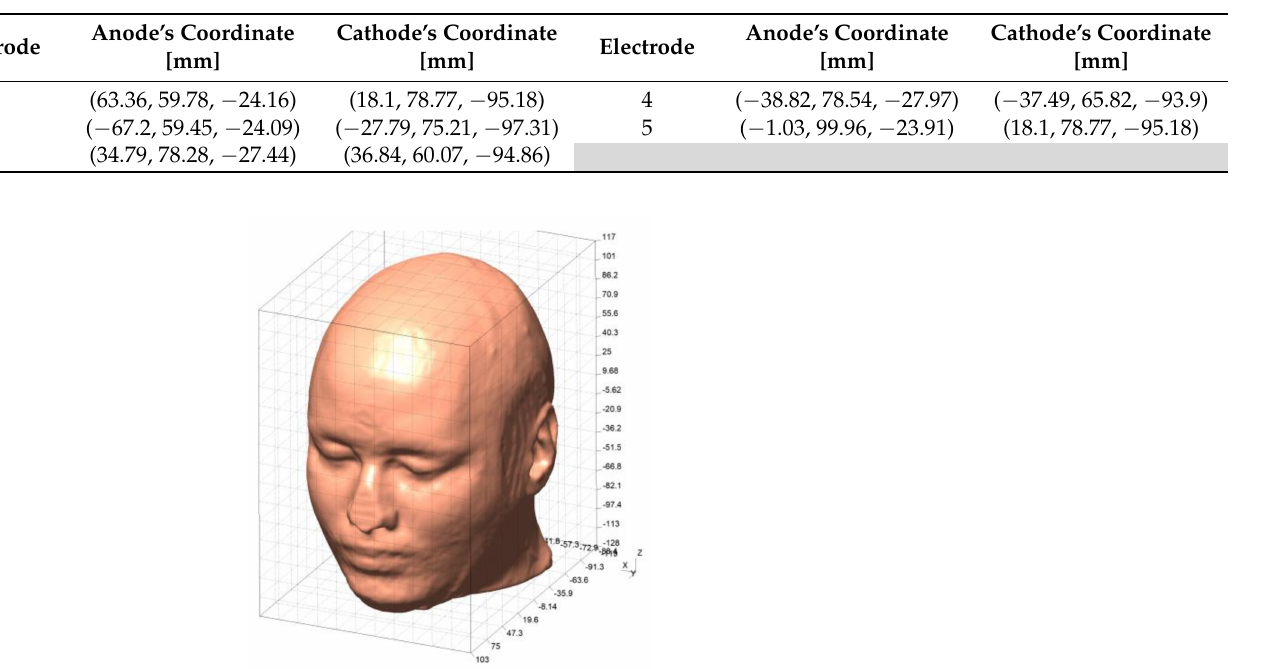
Table 2. Coordinates of each stimulus electrode on the human face.